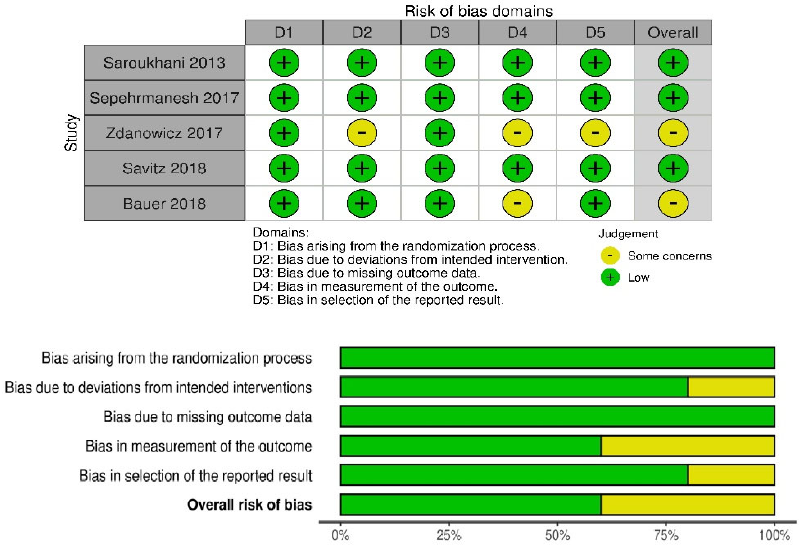
Figure 3. Risk of bias for interventional randomized studies separately and summarizing with Rob2